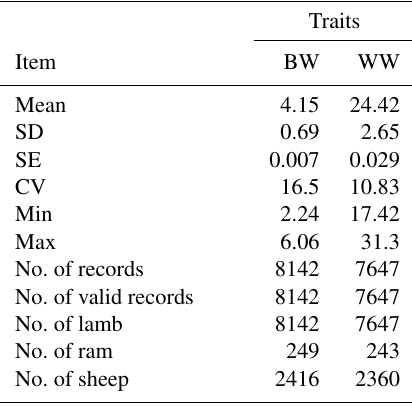
Table 1. The data structure of BW and WW for Awassi lambs.